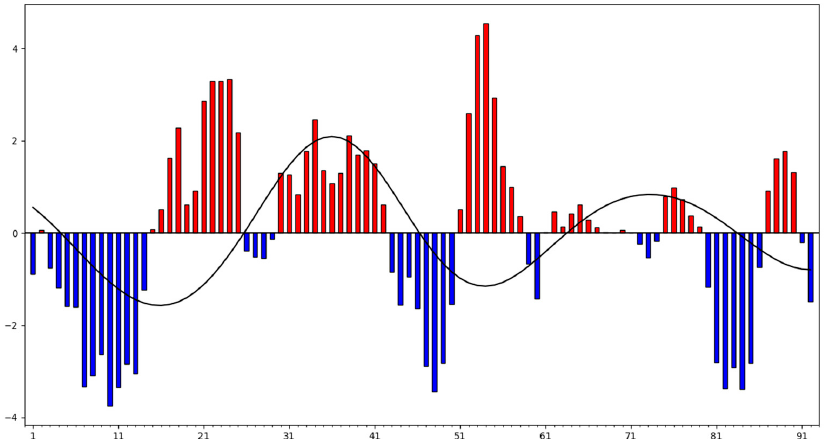
Figure 10. Evolution of precipitation anomalies (colored bars: red-positive, blue-negative) over southwestern China during 1998, and filtering curve (line).